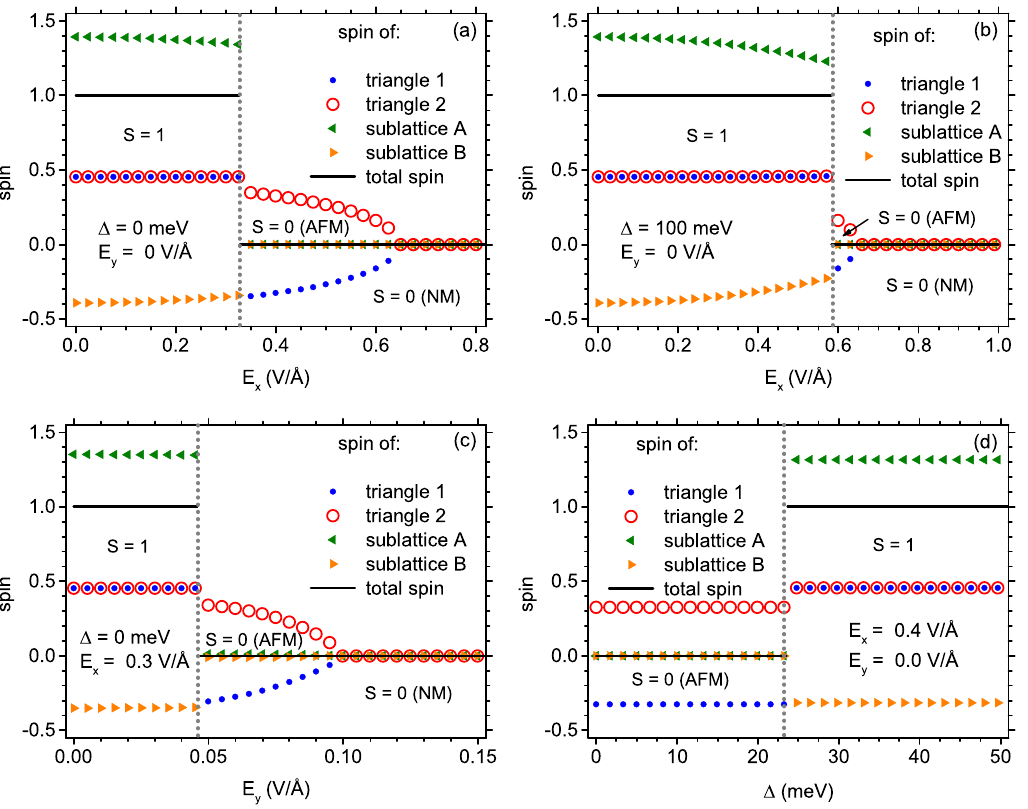
Figure 9. Total spin of the nanostructure and spins of sublattices and triangles as a function of: ( a ) electric field E x for E y = 0 and ∆ = 0; ( b ) electric field E x for E y = 0 and ∆ = 100 meV; ( c ) electric field E y for E x = 0.3 V/Å and ∆ = 0; ( d ) exchange energy ∆ for E x = 0.4 V/Å and E y = 0. Vertical dotted lines mark the points at which the state